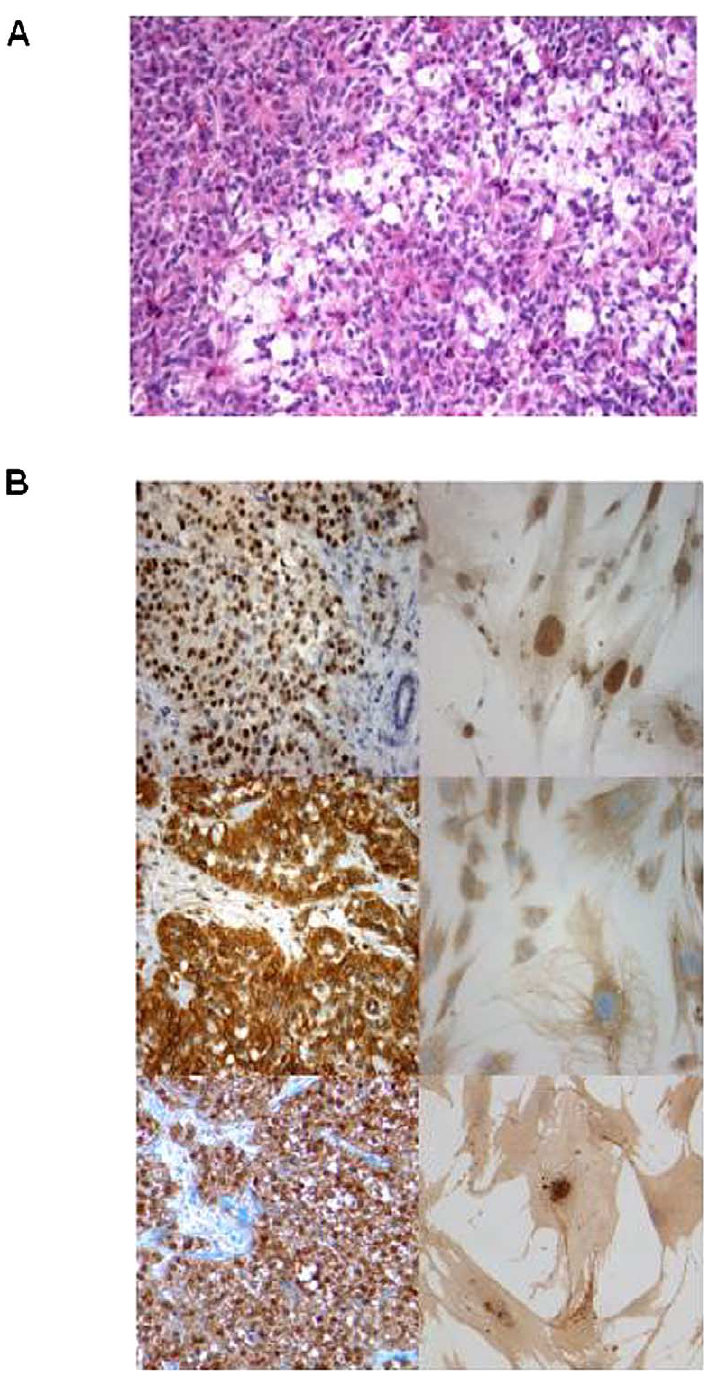
Fig. 1. Characterization of SPN tissue and cells. (A) Hematoxylin–eosin staining of SPN tissue in light microscope. (B) Immunohistochemical (on the left) and immunocytochemical (on the right) analyses of cyclin D1 (upper panels), vimentin (central panels) and β -catenin (lower